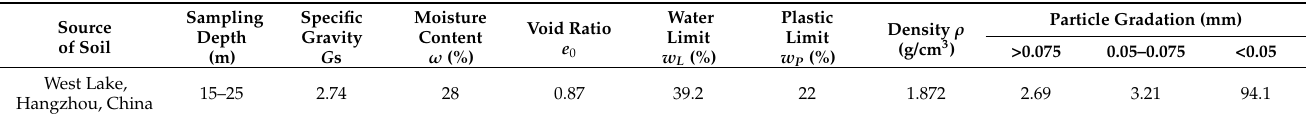
Table 1. Basic physical properties of clayey